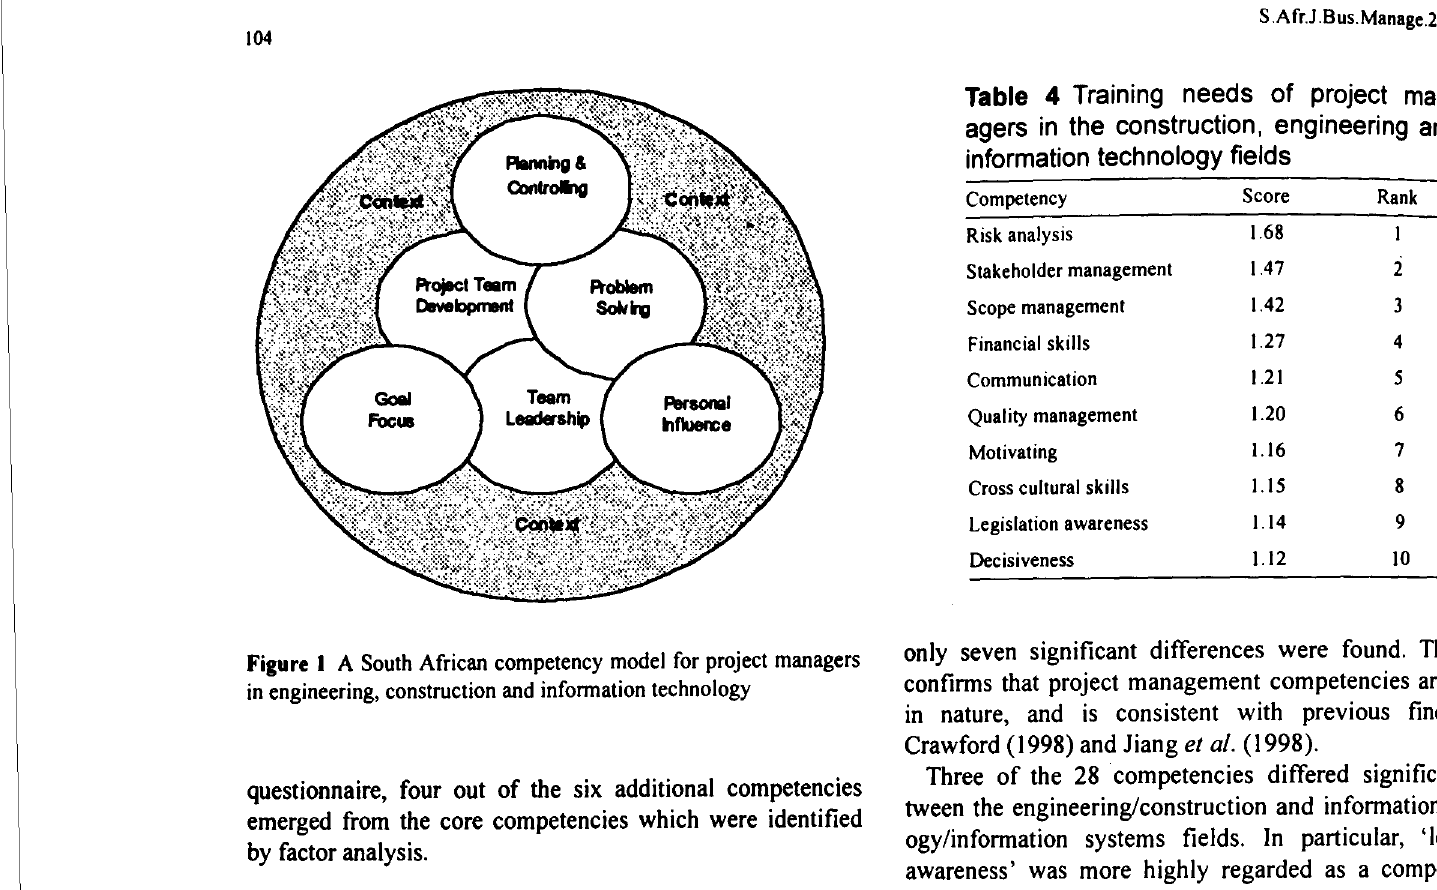
Table 4 Training needs of project man agers in the construction, engineering